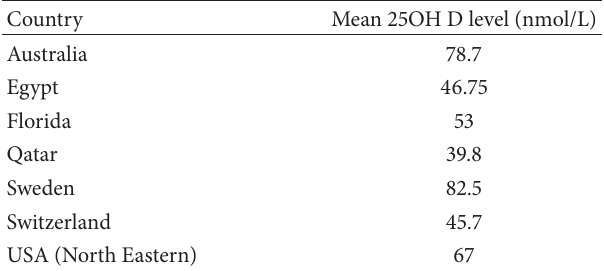
Table 1: VDR gene polymorphism and type 1DM. Table 2: Mean 25OH D level in T1DM in different